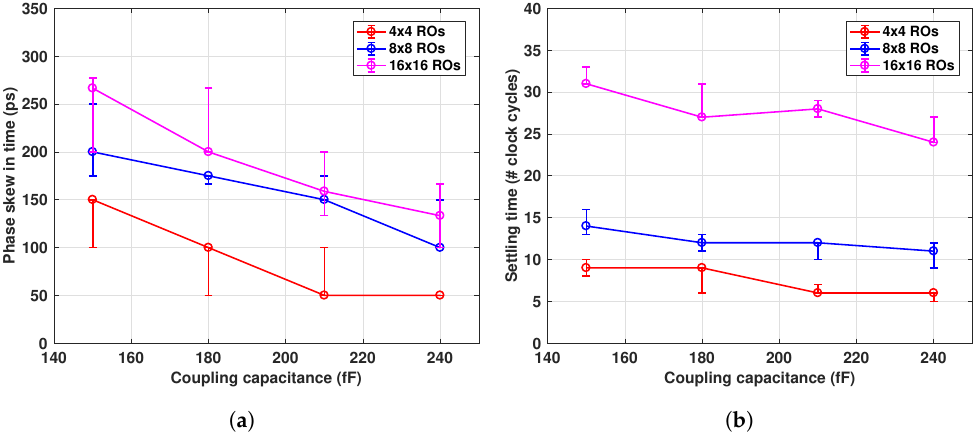
Figure 8. ( a ) Steady state phase skew and ( b ) Settling time for different network sizes and coupling capacitance. Settling time is defined by the phase mismatch below 1/(67%) of value obtained in ( a ); vertical bars indicate variation due to ± 10% mismatch in C c